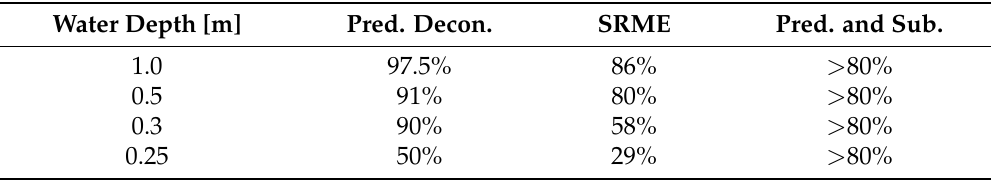
Table 4. Overview of attenuated multiple energy in percent compared to the reflection for each applied method for the synthetic constant-offset test scenarios. Water Depth [m] Pred.